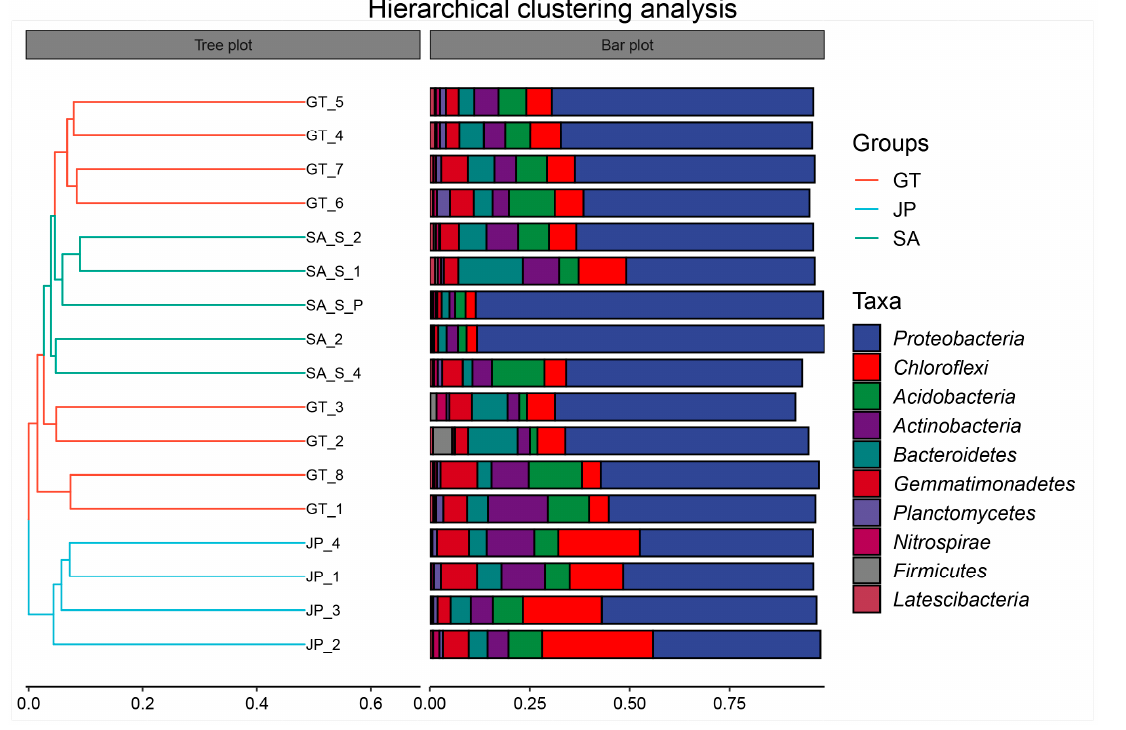
Figure 6. The hierarchical clustering analysis of bare flats (GT), Sueada salsa areas (JP), and S. alterniflora Loisel areas (SA). On the left is the hierarchical clustering tree diagram, where samples are clustered according to their similarity. The shorter the branch length between samples, the more similar the two samples are. On the right is a stacked bar chart of the top 10 genera in abundance.